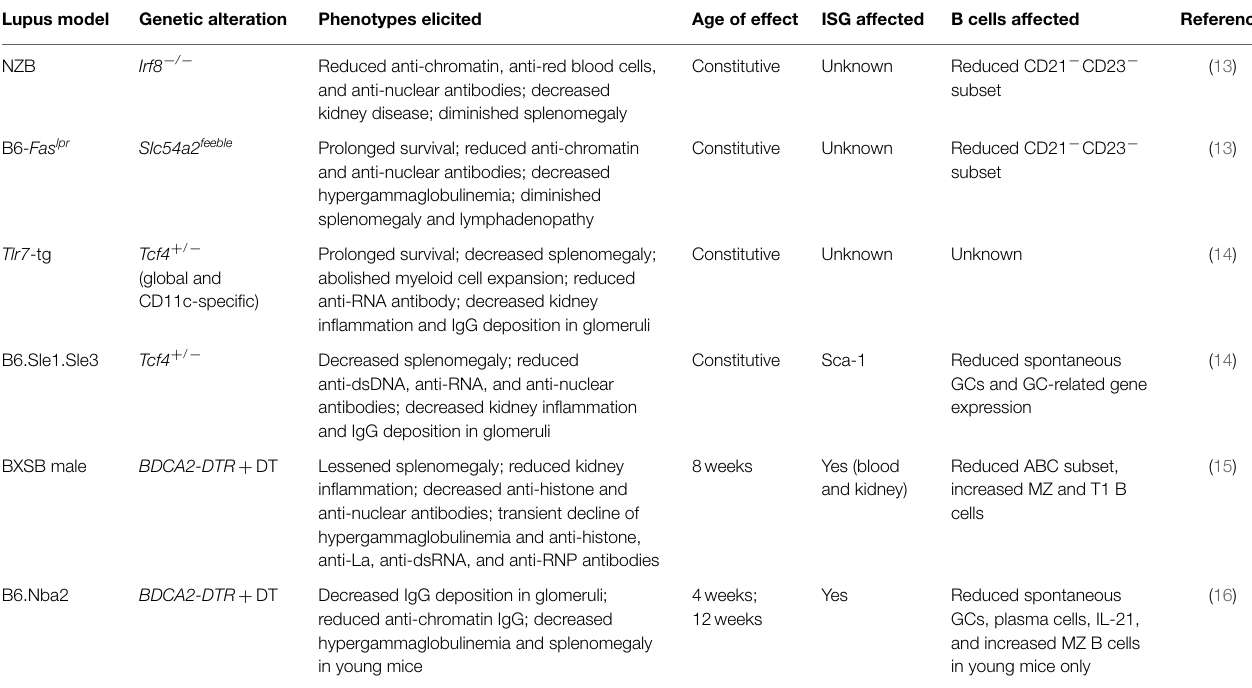
TABLE 1 | Effects of pDC depletion in different spontaneous lupus models